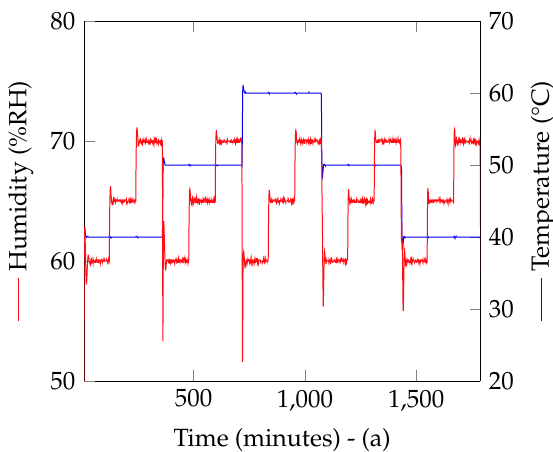
Figure 4. Temperature and humidity measured with an electronic sensor inside the climatic chamber during the